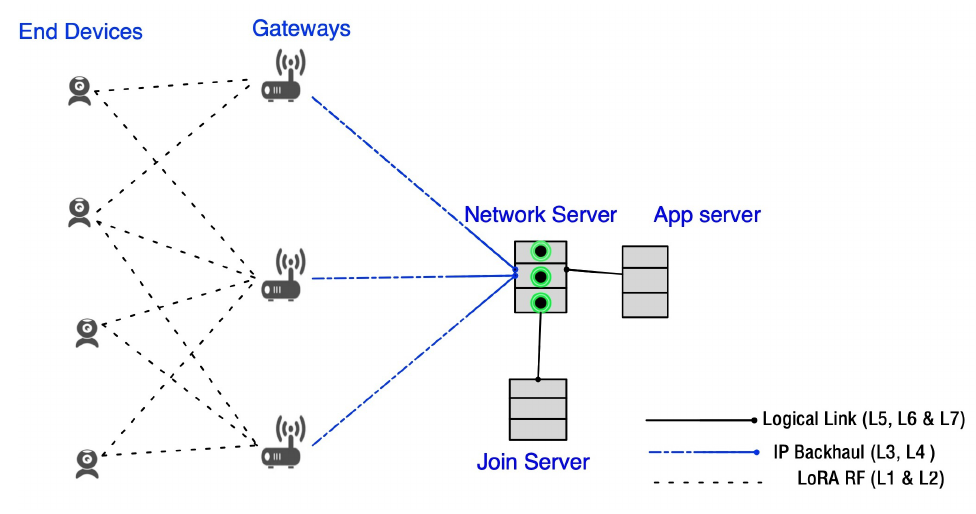
Figure 1. LoRaWAN network architecture.